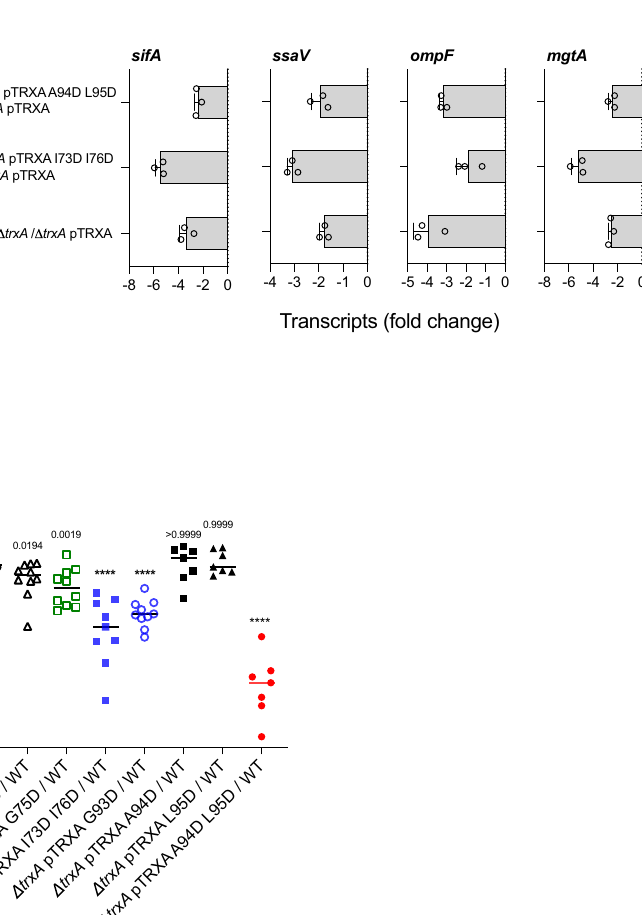
experiments.Geneexpressionwasnormalizedtointernallevelsofthehousekeeping gene rpoD . Transcripts downregulated ≥ 2-fold were considered signi fi cant. c Bacterial burden in spleens and livers of C57BL/6 mice 96h after i.p. inoculation with~1000CFU ofa mixture containing equalnumbersof wild-type Salmonella and isogenic strains expressing trxA interfacial mutations. Horizontal bars represent the median from 7 – 10 mice collected in 2 independent experiments ( n =7, 7, 10, 10, 9, 10, 7, 7, 7, 7). Exact p values are shown, and p <0.0001 as calculated by one-way ANOVAwhencomparedto Δ trxA pTRXA/WT.df=8;F=1375and1429forspleenand liver, respectively. Source data are provided as a Source Data fi (Fig. S7k). In addition to participating in the interfacial surface that mediates binding to TrxA (our data above), Arg 182 is involved in dimerization 38 . This might contribute to the stronger intracellular growth defect of ompR R182D Salmonella compared to controls expressingthe ompRA136D,I138D, or Y230D alleles.Forthisreason,we have chosen Salmonella strains bearing OmpR A136D, I138D or Y230D mutations for further testing. OmpR has been incorporated into the circuitry that activates the transcription of the Salmonella ssrA gene 24 . Salmonella strainsexpressingtheA136D, I138D,orY230D mutations in OmpR interfacial residues express lower levels of the ssrA gene 8 h after infection of J774 cells (Fig. 7b). Salmonella strains bearing mutations in ompR interfacial residues also express lower levels of the sifA -encoded SPI-2 effector (Fig. 7b). Salmonella expressing OmpR A136D, I138D or Y230D variants, which do not bind to thioredoxin but associate with RNA polymerase as well as cognate sensor kinase and DNA, are attenuated in an acute model of infection (Fig. 7c). Our investigations demonstrate a critical role for the interactions of OmpR with thioredoxin in Salmonella pathogenesis. The role played by OmpR interfacial residues in Salmonella pathogenesis can be explained by the contribution that these residues play in the global